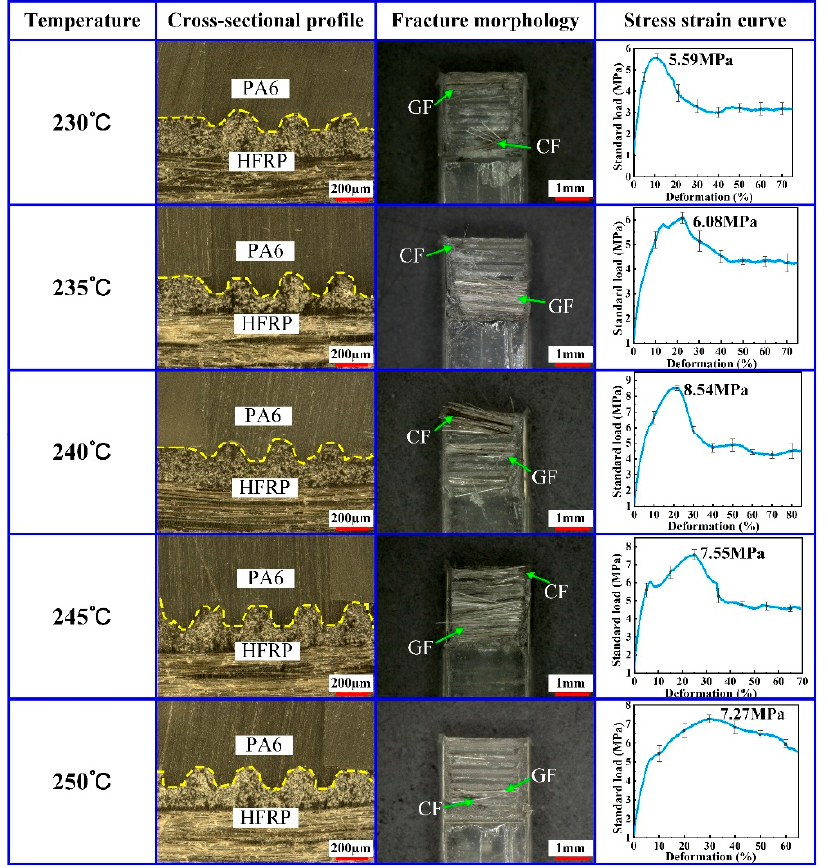
Figure 3. Effect of mold temperature on the injection molding quality of composite parts.